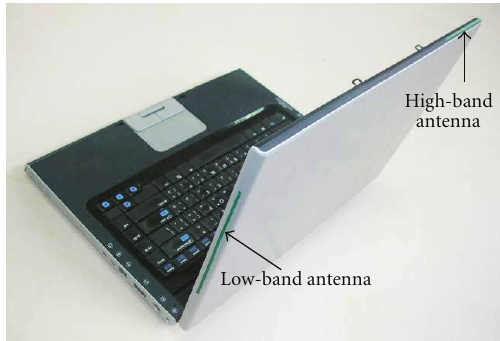
Figure 14: The third dual antenna configuration on a laptop